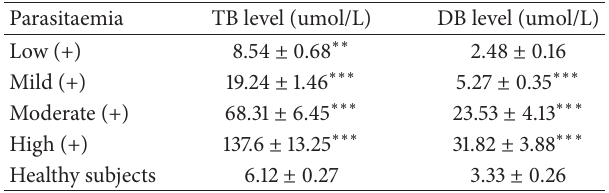
Table 6: Mean total and direct bilirubin levels in parasitaemia P. falciparum malaria and healthy control